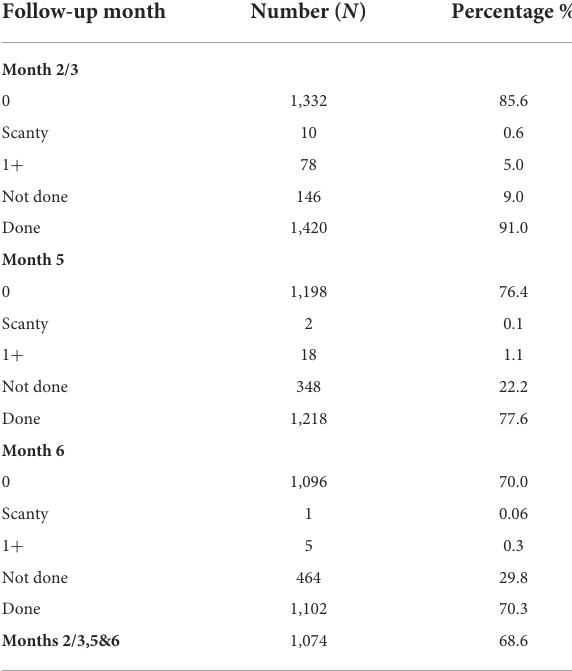
TABLE 2 Analysis of availability of Acid-Fast Bacilli (AFB) Sputum Follow up result at months 2/3, 5 and 6 in Tuberculosis Treatment Register ( n = 1,566).